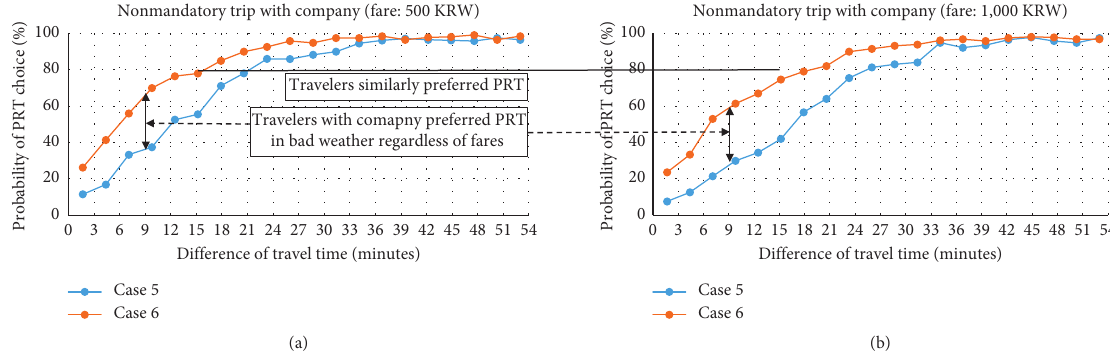
Figure 8: Impacts by weather and fare on PRT choice in the nonmandatory trip with